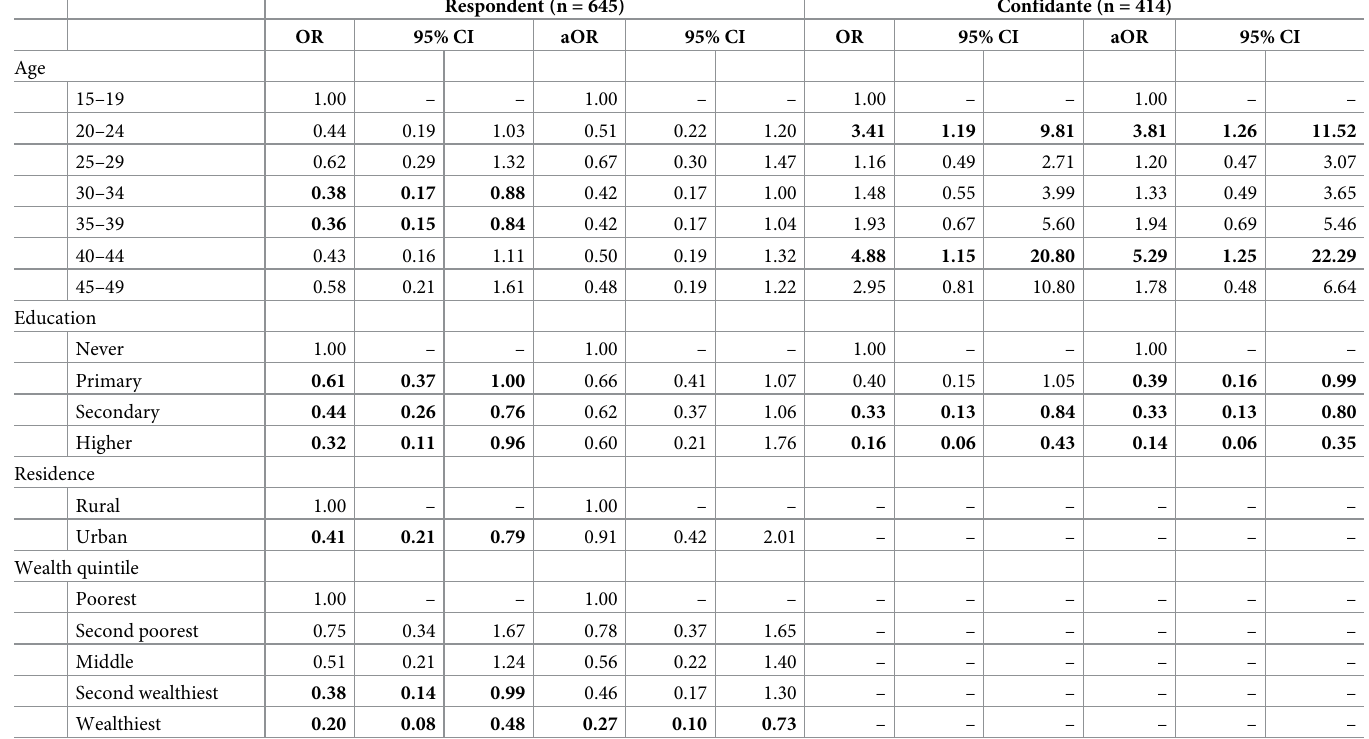
Table 4. Bivariate and multivariate regression of characteristics associated with experiencing a most unsafe likely-abortion among Coˆte d’Ivoire respondents and confidantes age 15 to 49 1